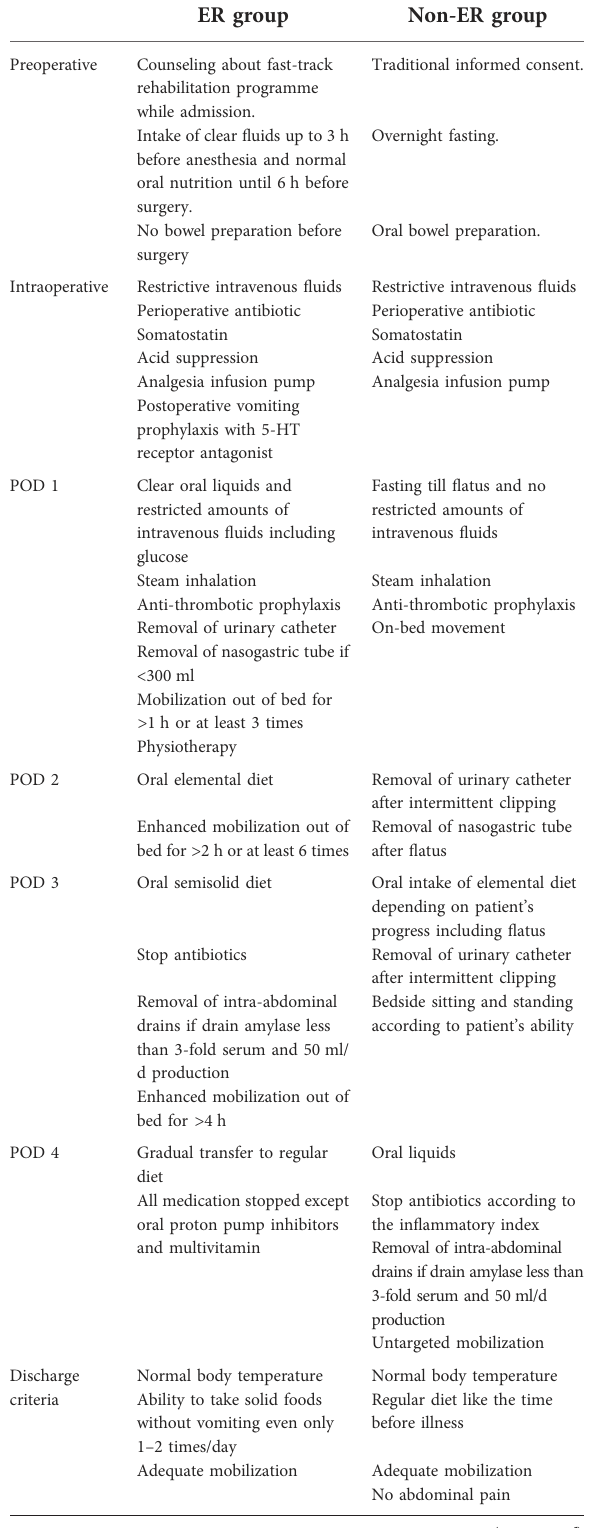
TABLE 2 Protocols of the ERAS program and traditional care for patients receiving LPD. All items involved in the protocols were list in the table including preoperative, intraoperative and post-operative 1 – 4